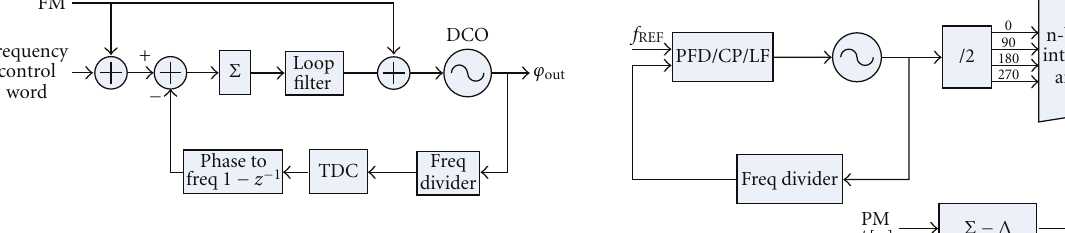
Figure 3: Open-loop phase modulator